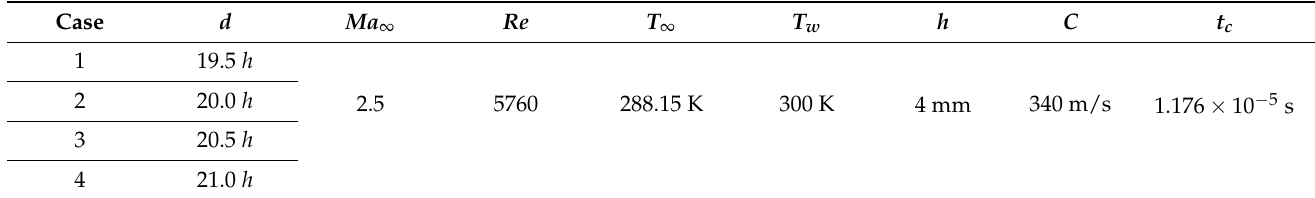
Table 1. Parameters for the LES cases.